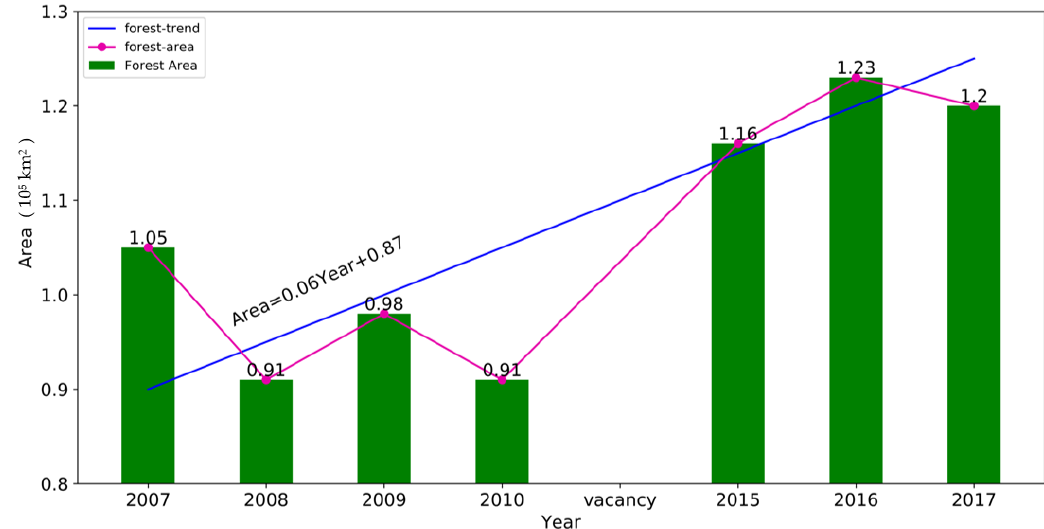
Figure 11. Forest variation in the forest cover in the Loess Plateau and the trend of the forest variation cover from 2007 to 2017.